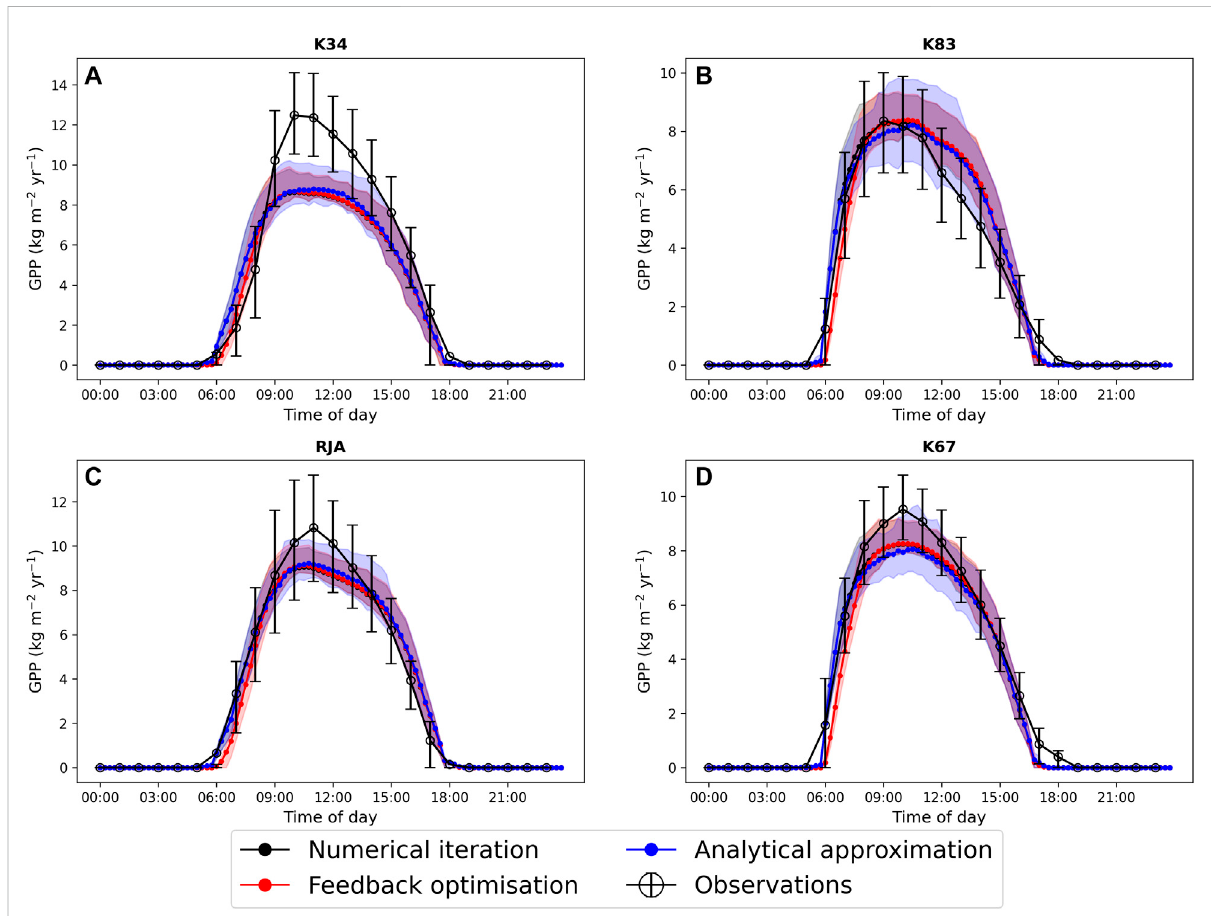
A comparison of the average diurnal cycle of predicted gross primary production (GPP, kg C m − 2 yr − 1 ) from JULES-SOX solved using three differentmethods(1.Numericaliteration (black), 2.Feedbackcontrol (red),3.Asemi-analyticalapproximation(blue)))and observed GPPatfoursites in the Amazon rainforest. (A) LBA-K34 Reserva Cuieiras, Manaus Brazil; (B) LBA-K83 Tapajos National forest, Santarem Brazil; (C) LBA-RJA Reserva Jaru; (D) LBA-K67TapajosNationalforest,SantaremBrazil.ObserveddataisfromSaleskaetal.(2013).Errorbarsandshadedareasrepresentthe 25% and 75% uncertainty